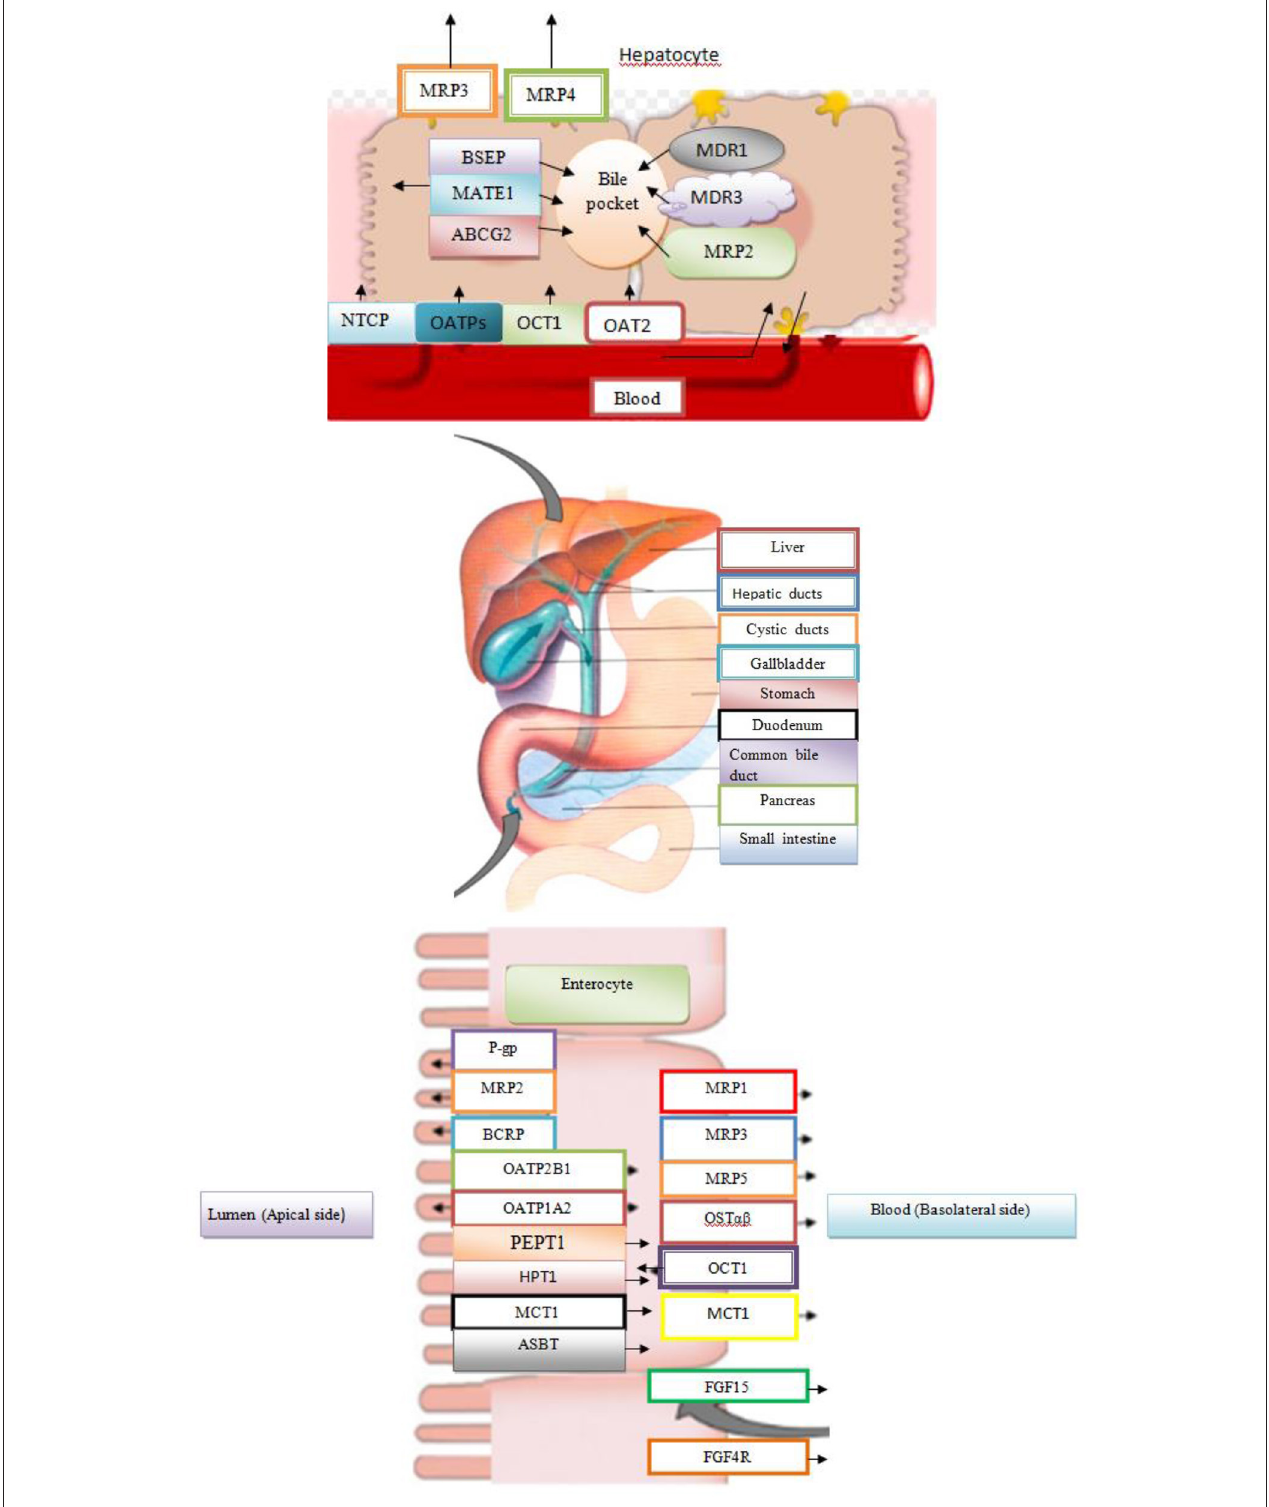
FIGURE 3 | Bile Acid Metabolism in Liver and